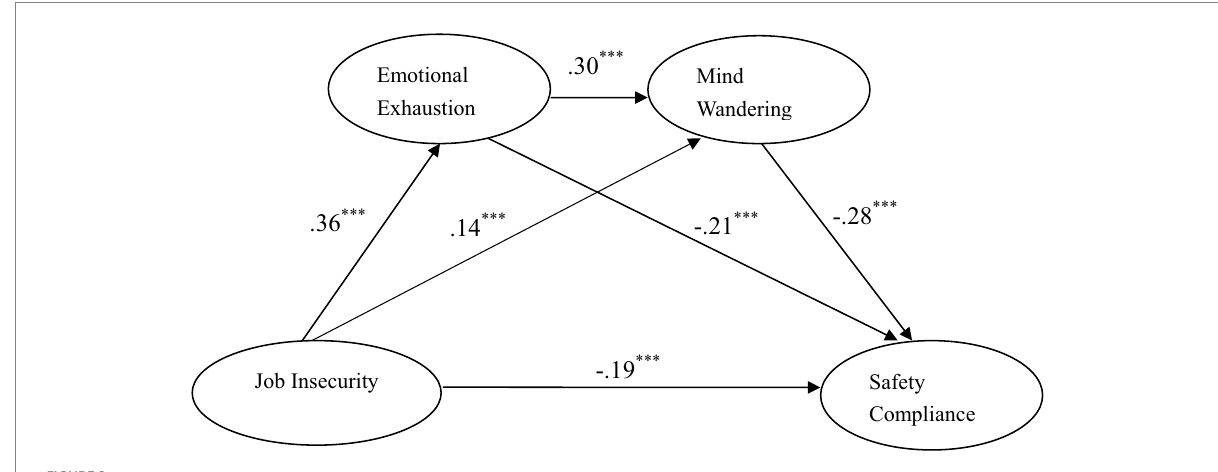
FIGURE 2 The chain mediating effect of miners’ emotional exhaustion and mind wandering ( N = 447). *** p < 0.001.